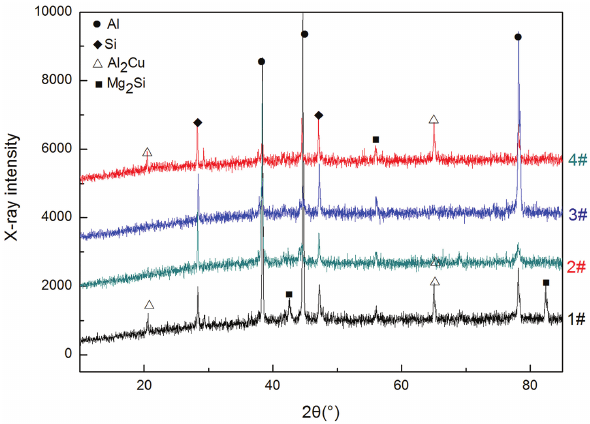
Figure 7: XRD patterns of the test specimens with different treatment condition: (1#) as-cast state; (2#) solution treated; (3#) aging- treated at 180 ℃ for 2h; (4#) aging-treated at 180 ℃ for